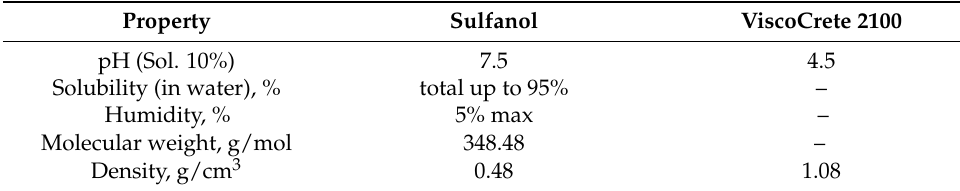
Figure 1. Schematic depiction of the structure of multilayer polyhedral nanoparticles. Table 1. Surfactants’ characteristics.